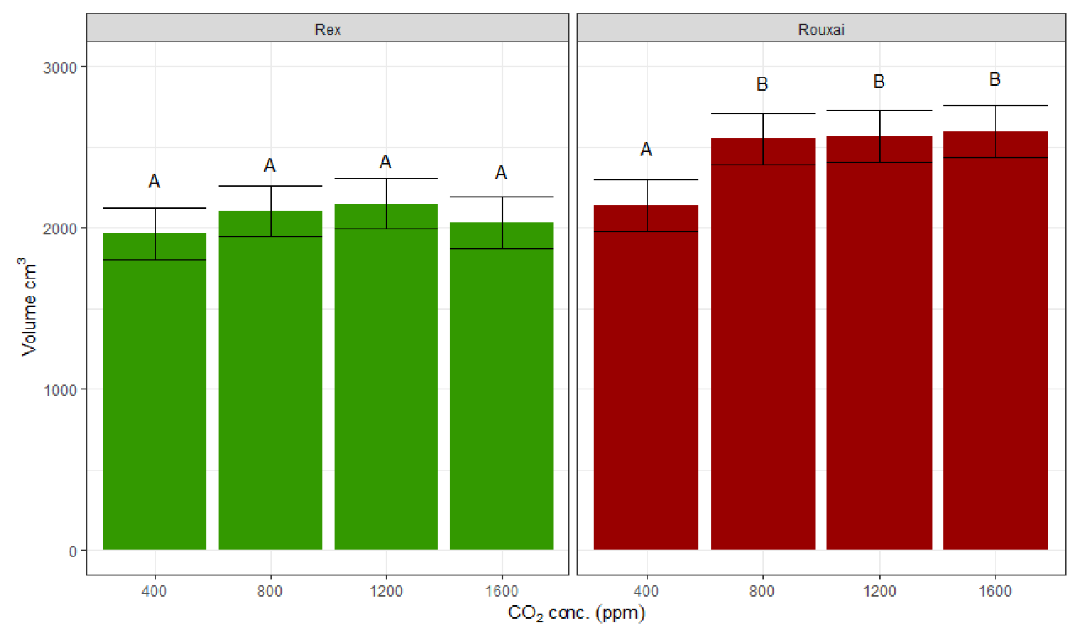
Figure 5. Volume of lettuce ‘Rex’ and ‘Rouxai’ after 21 days in response to CO 2 concentration. Data represent estimated marginal means and standard error as calculated by five plants per cultivar in each of four replicate crop cycles in a complete randomized block design. Letters represent mean separation comparison using Tukey’s Honestly Significant Difference (alpha = 0.05).